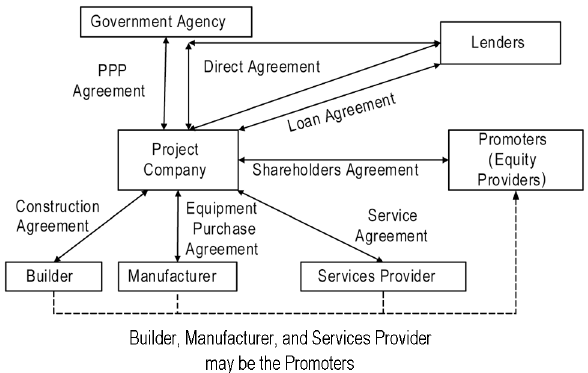
Fig. 1. A representatively contractual framework among stake- holders in